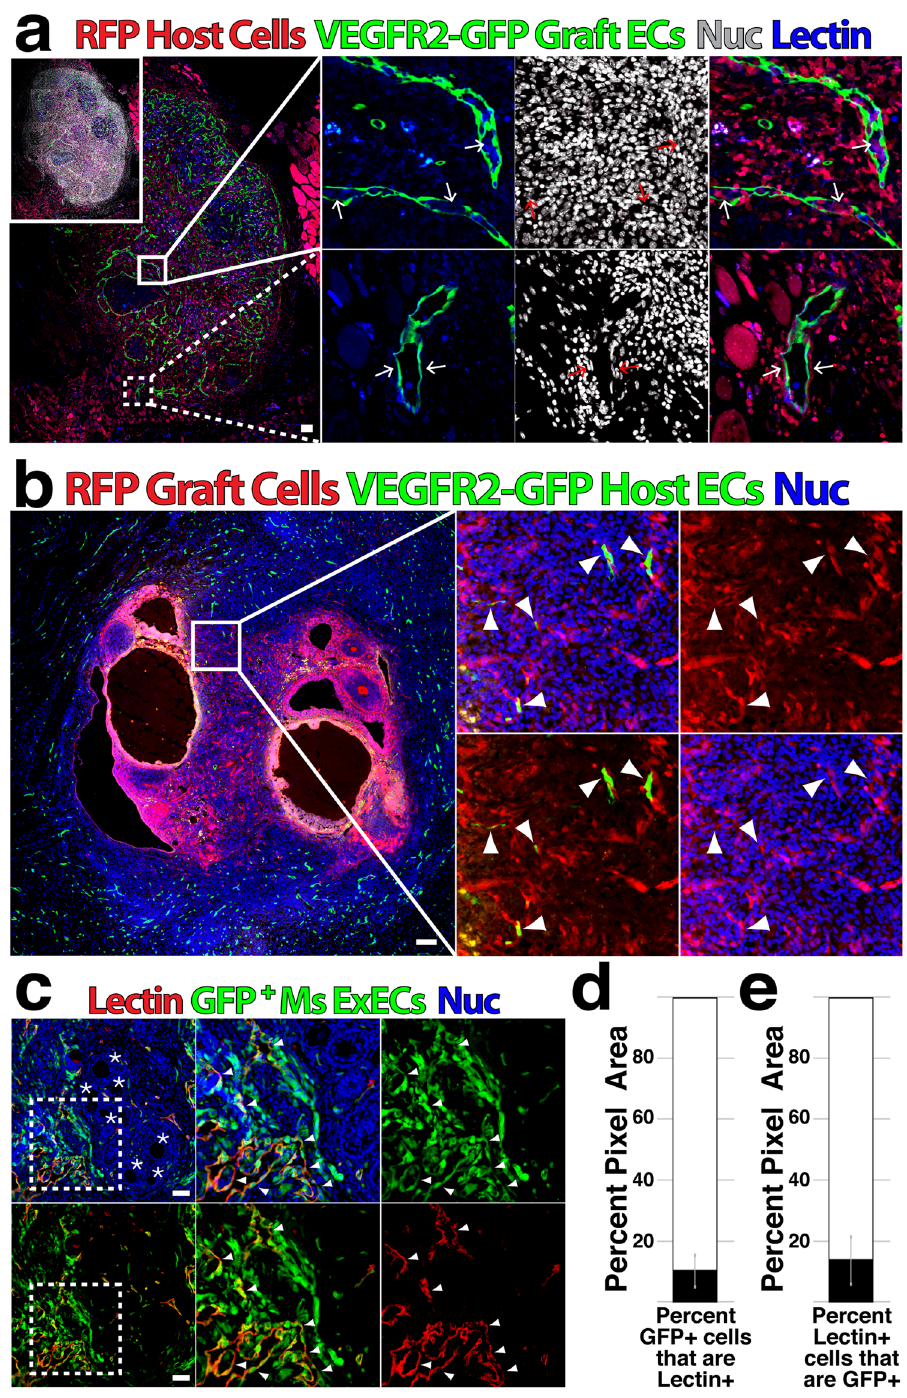
Figure 1. Host, graft and exogenous ECs contribute to revascularization of transplanted ovarian tissue. ( a ) Ovaries from VEGFR2-GFP mice were transplanted into RFP host; following two weeks, mice were injected with GIB4 lectin to label functional vessels and grafts were isolated to determine transit of host and graft ECs. ( b ) Ovaries from RFP mice were transplanted into VEGFR2-GFP host; following two weeks, grafts were isolated to assess infiltration of host vessels. ( c ) Ovaries were isolated from wild-type mice and co-transplanted with GFP + ExECs derived from mouse heart; following two weeks mice were injected with GIB4 lectin to label functional vessels and grafts were isolated to assess contribution of ExECs to functional vessels. ( d ) Out of all GFP + ExEC area, the percentage of Lectin + area was measured. ( e ) Out of all Lectin + area, the percentage of GFP + ExEC area was measured. Insets in ( a – c ) are enlarged in the associated box. Error bars in (d and e) represent standard deviation between 10 representative tissue sections from 2 mice replicates. Scale bars = 100 μ